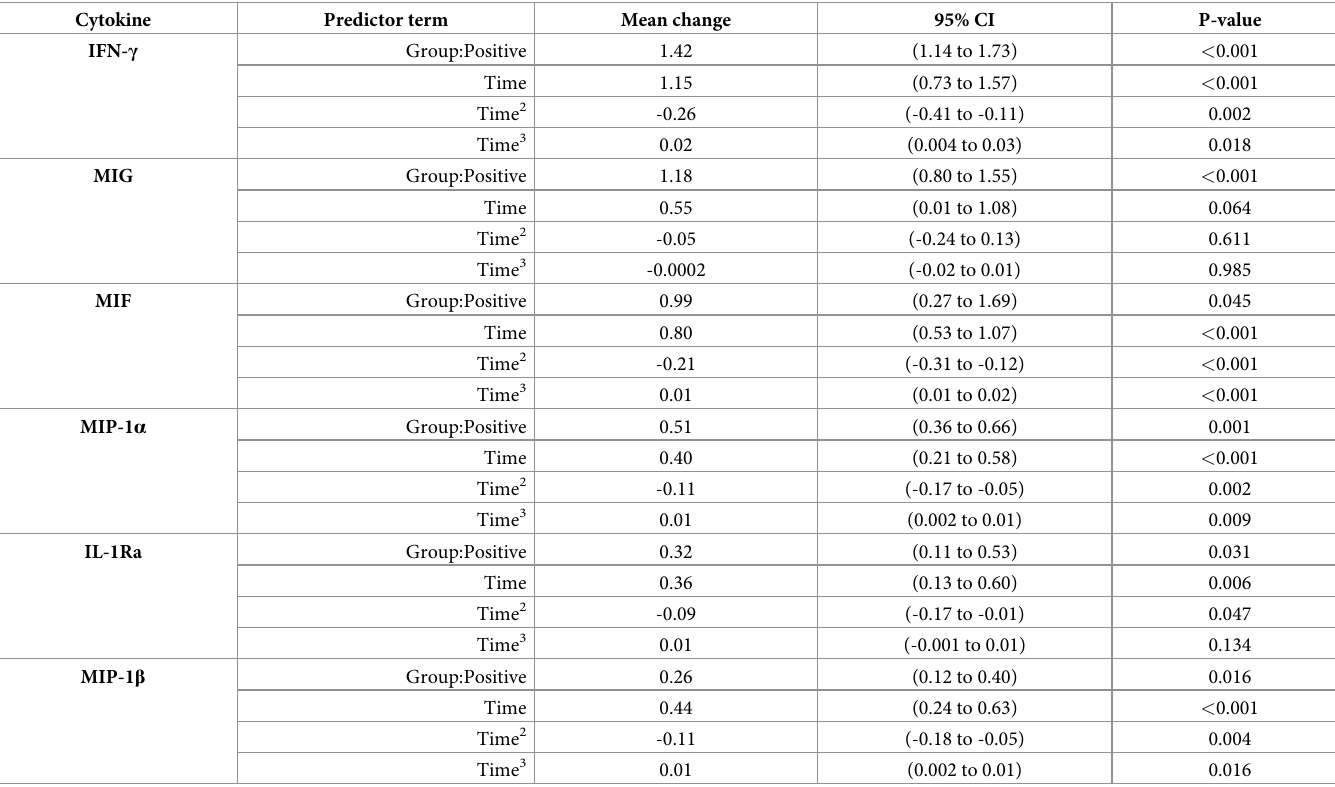
Table 2. Temporal change in cytokine